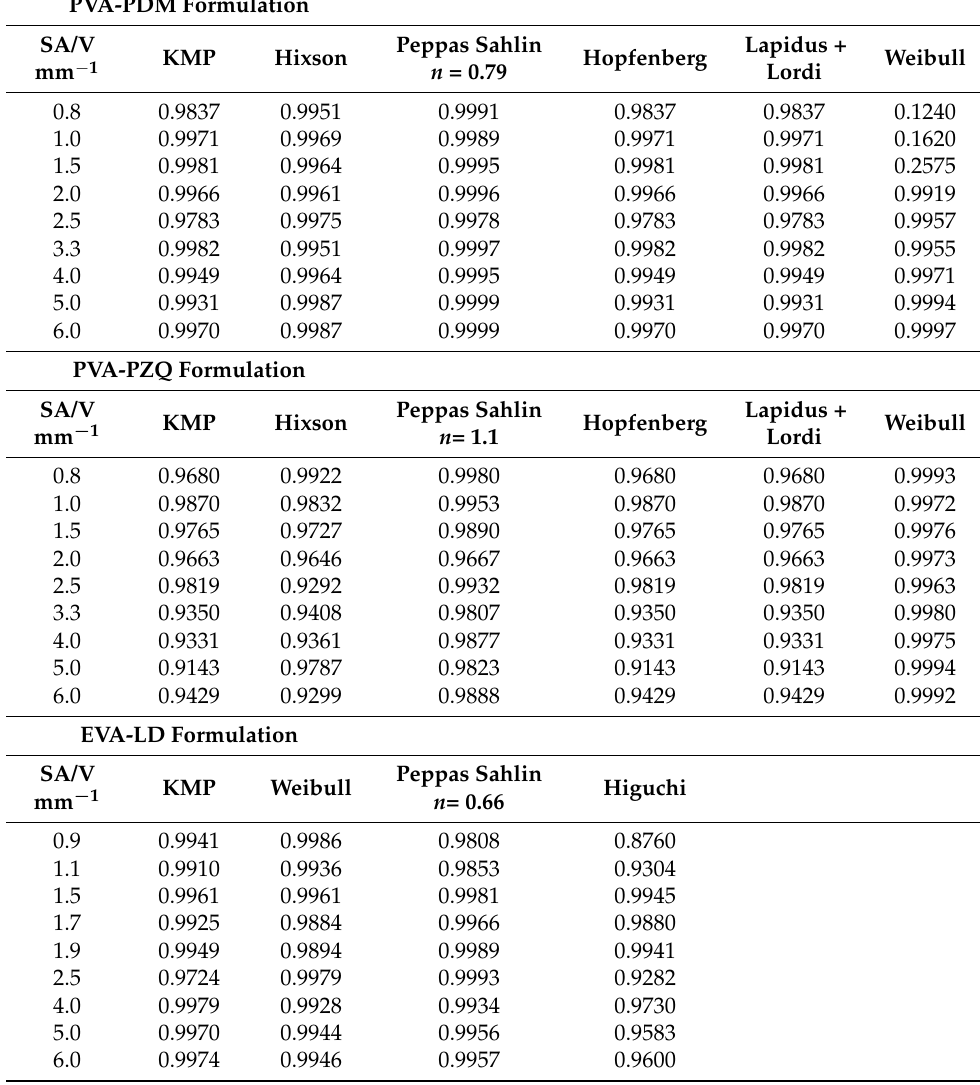
Table 7. R 2 values of model